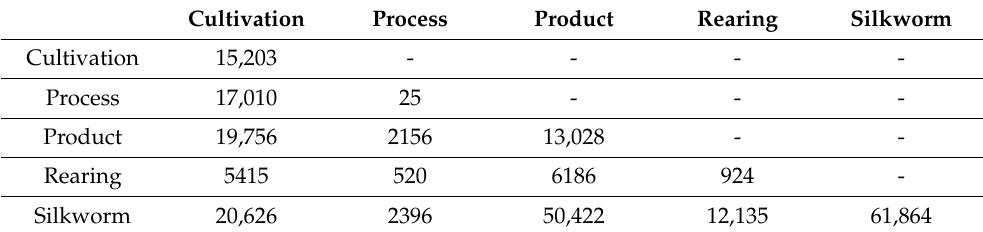
Table 10. Number of interrelationships among clusters.